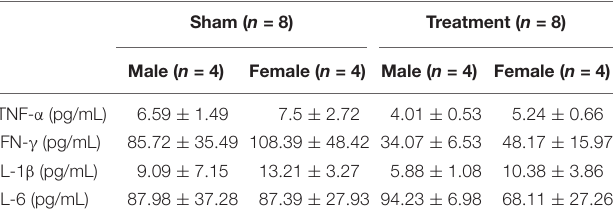
TABLE 2 | Baseline plasma cytokine